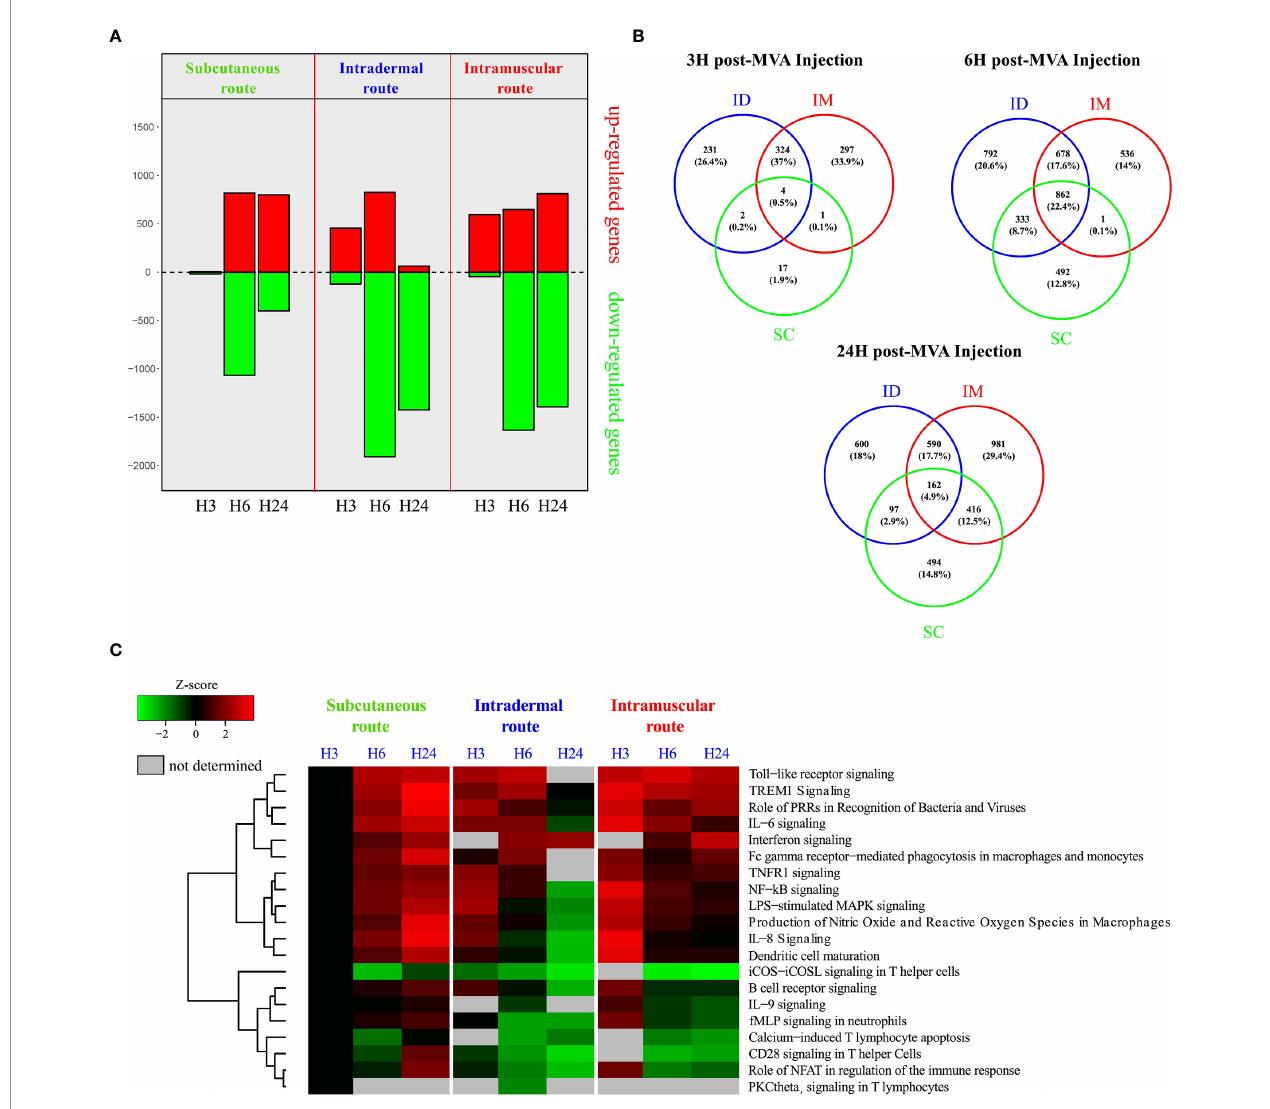
FIGURE 5 | Transcriptomic analysis of systemic early responses induced by SC/ID/IM MVA administration. (A) Histogram of the number of signi fi cantly up-and downregulated genes at 3, 6, and 24 after MVA injection in the whole blood relative to baseline (0 h) for each administration route. Downregulated genes are represented in green and upregulated genes in red. (B) Venn diagrams showing the overlaps between the differentially expressed genes for each administration route at 3, 6, and 24 h after MVA injection. (C) Heatmap representation showing functional enrichment scores for signi fi cantly over-represented canonical pathways related to immune processing and cytokine signaling with a p-value < 10 -3 . The color scale corresponds to the Z-score, which is proportional to the upregulation (in red) or downregulation (in green) of the